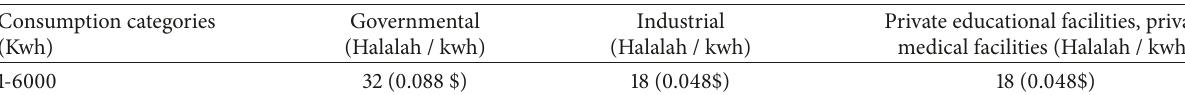
Table 5: Consumption tariff.